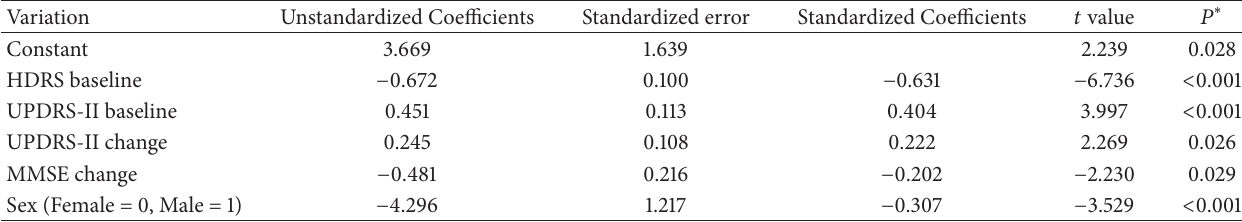
Table 3: Clinical and demographic correlates of change in HDRS.